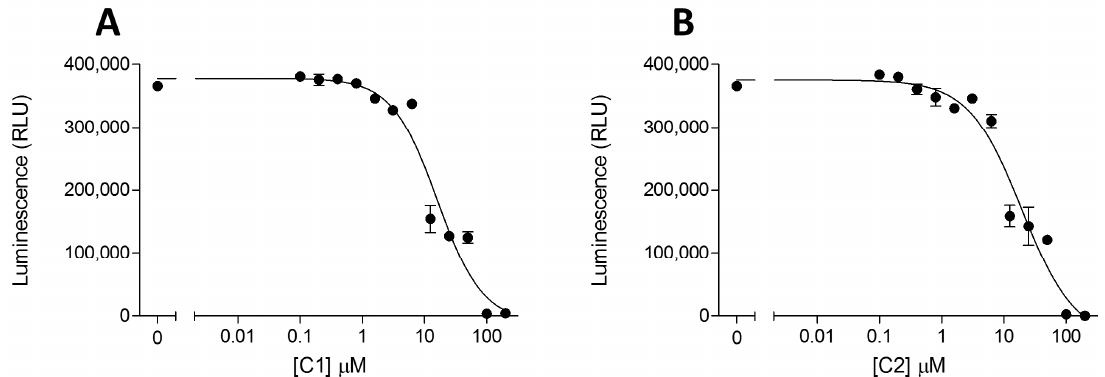
Figure 2. Cytotoxicity data of compounds 1 (panel A ) and 2 (panel B ) in Vero cells. Cells were treated with several concentrations of either compound 1 (C1), compound 2 (C2), or DMSO at equivalent concentration, as described in Materials and Methods. After 48 h, cellular adenosine triphosphate (ATP) was detected and measured by chemiluminescence. Data is expressed as mean ± standard error of three independent experiments. The curve was obtained by nonlineal regression analysis (four parameters logistic, variable slope model) as implemented in Graphpad Prism.